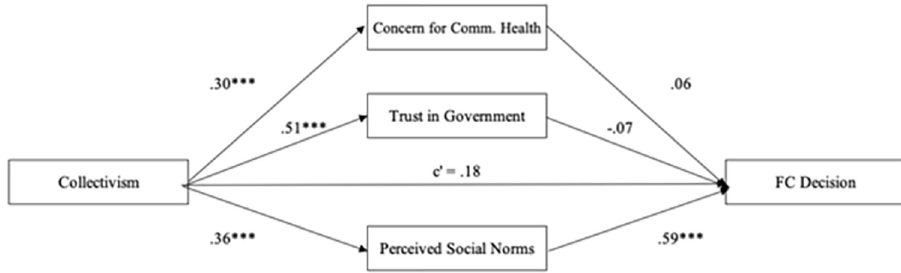
Fig 2. Mediation model for FC decision. The relationship between collectivism and compliance with wearing a face covering when not required as mediated by concern for community health, perceived social norms, and trust in government. Numbers are standardized regression